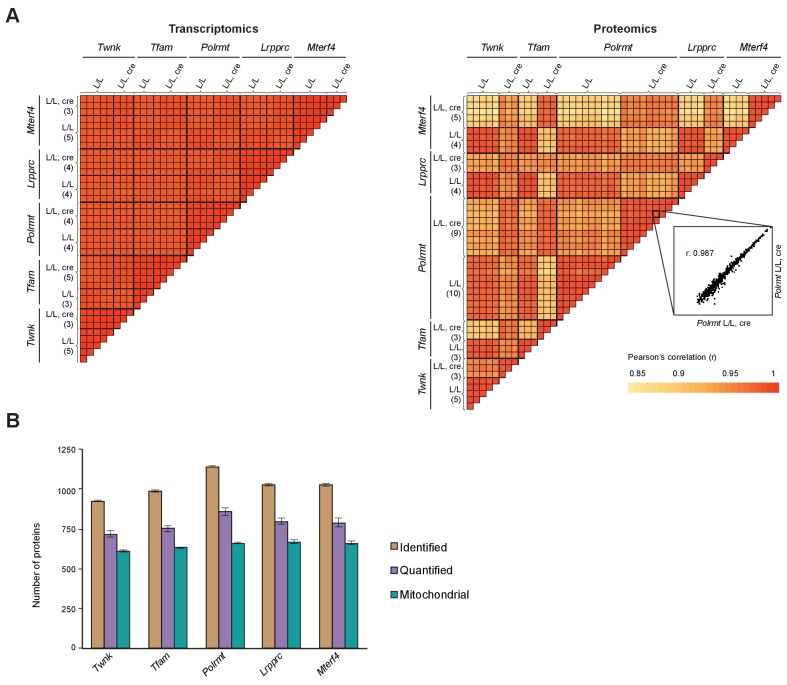
High reproducibility of the transcriptomic and mitoproteomic data.(A) Reproducibility of the RNA-Seq (left) and label-free mass spectrometry (right) data is illustrated in heatmaps representing the Pearson’s correlation coefficient of all samples of the five different conditional knockouts (L/L, cre) and their corresponding controls (L/L) with the same scale; as an example of reproducibility a scatter plot of the label-free protein intensity values in two Polrmt L/L, cre samples and their correlation coefficient is shown. The number of biological replicates is indicated in parenthesis. (B) Number of identified (851 to 1348 proteins), quantified (673 to 1039 proteins) and mitochondrial proteins (586 to 704 proteins) across all L/L, cre hearts compared to corresponding L/L; error bars: ±SEM.